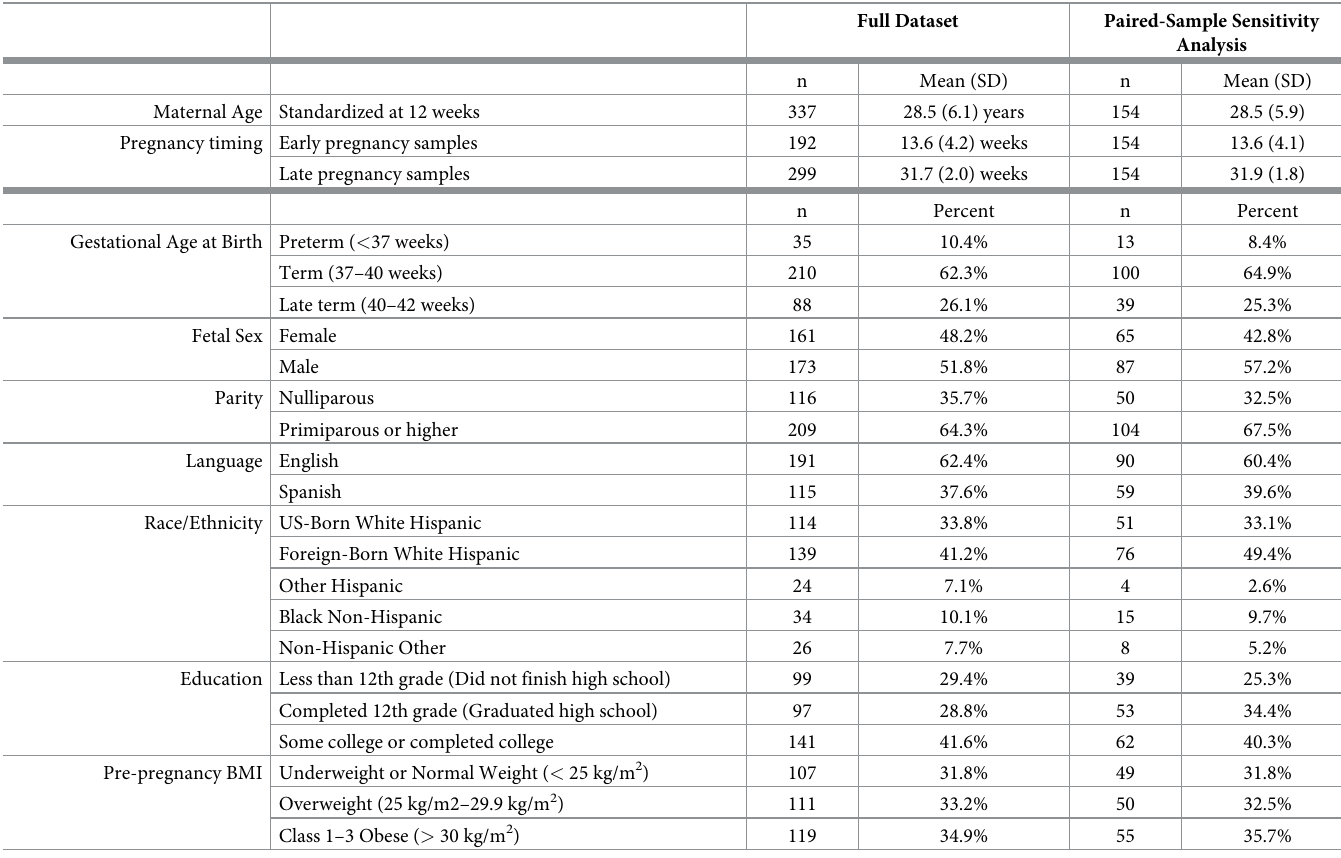
Table 1. Demographics of the miRNA pregnancy